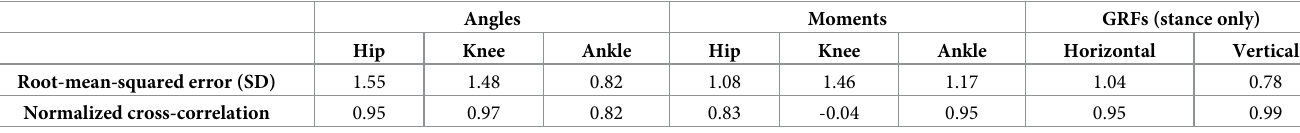
Table 1. Similarity metrics between simulated and experimental data for self-selected